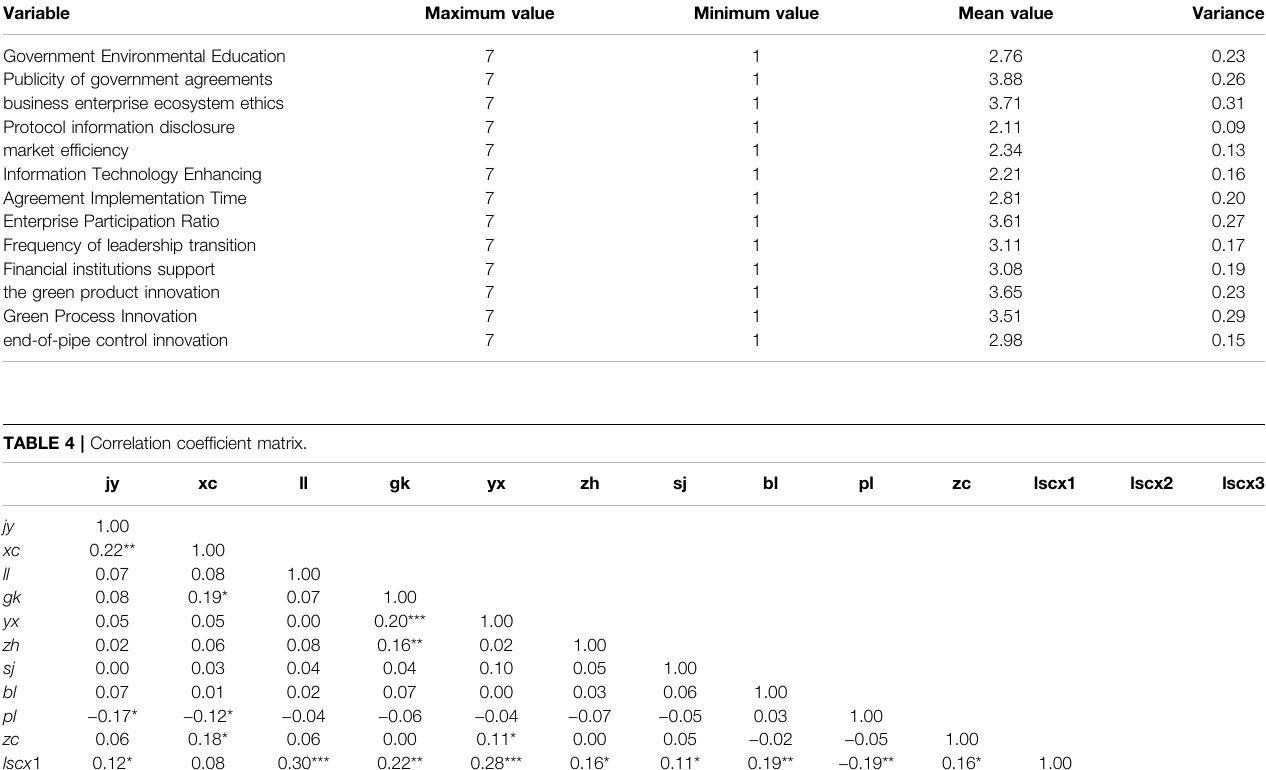
TABLE 3 | Descriptive statistics of measuring variables. Variable